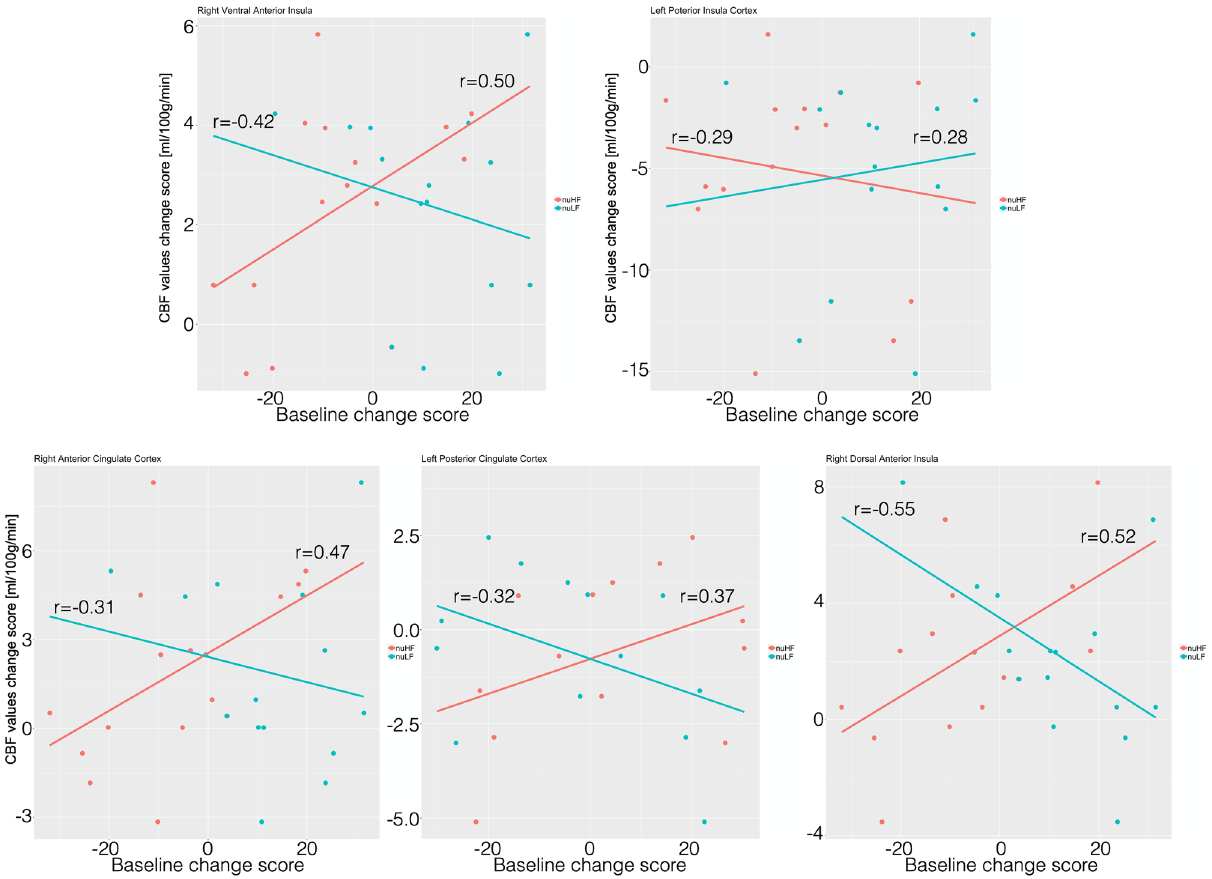
and nuHF (red line) and nuLF (cyan line) changes in the treatment